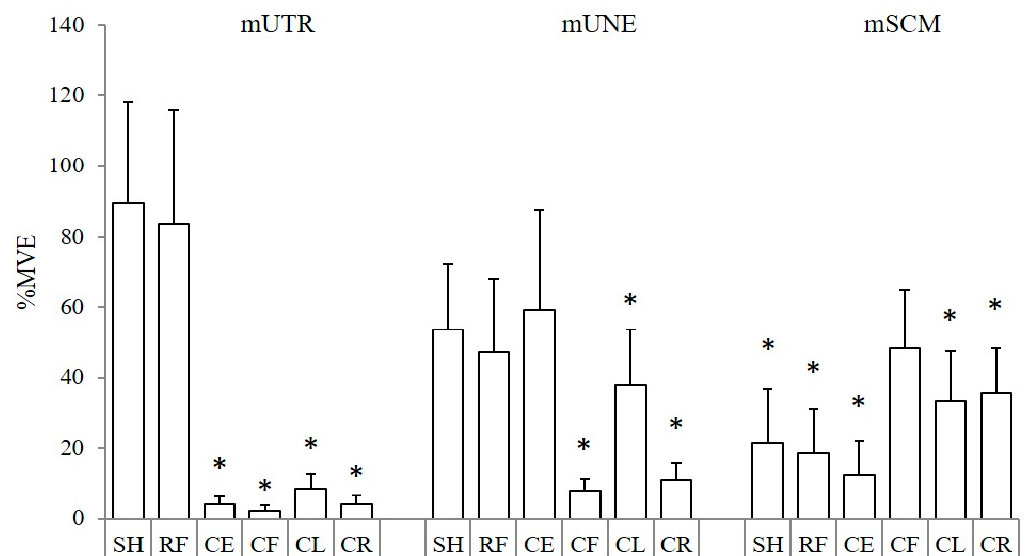
Figure 2. The muscle activity of the upper trapezius muscle (mUTR), upper neck extensors muscles (mUNE) and sternocleidomastoideus muscles (mSCM) were compared in six different types of exercises. The highest muscle activation (%MVE) was found during SH for mUTR, during CE for mUNE and during CF for mSCM. * marks exercises with significantly lower activation than the exercise inducing the highest muscle activation.